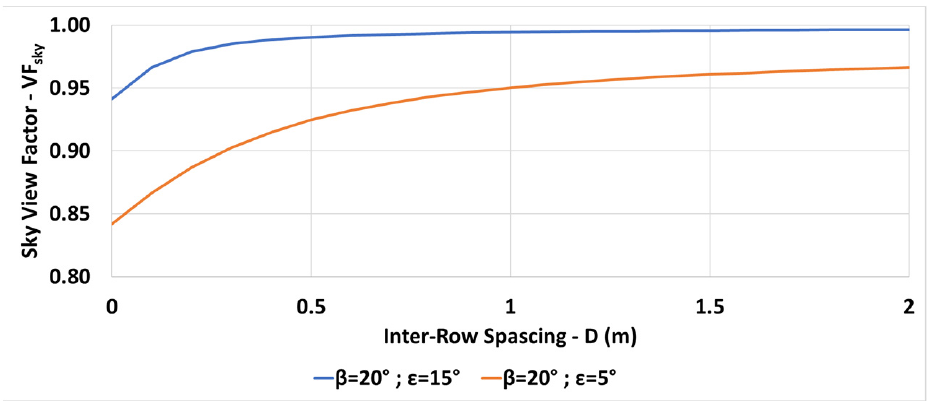
Figure 17. Variation of the sky view factor on an inclined plane.